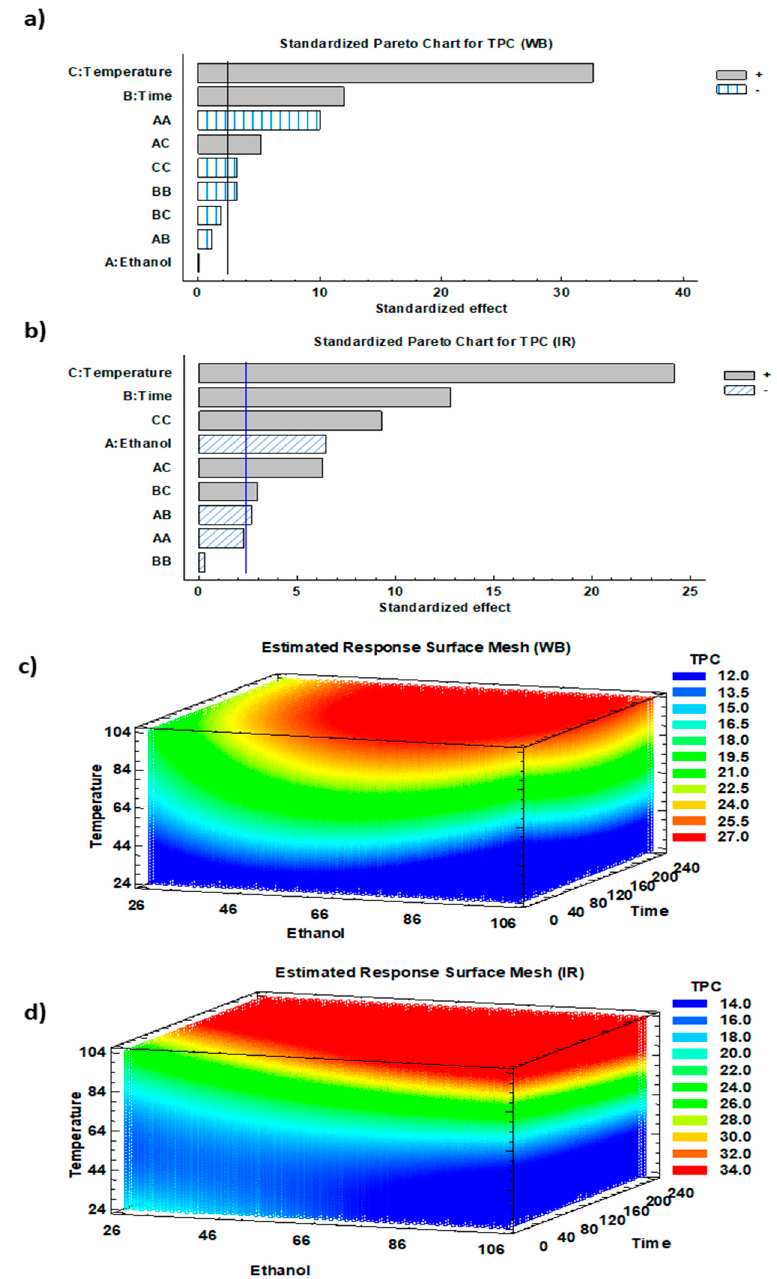
Figure 3. ( a , b ) Standardized Pareto charts and ( c , d ) the corresponding estimated response surface Figure 3. ( a,b ) Standardized Pareto charts and ( c,d ) the corresponding estimated response mesh of TPC for WB and surface mesh of TPC for WB and IR.